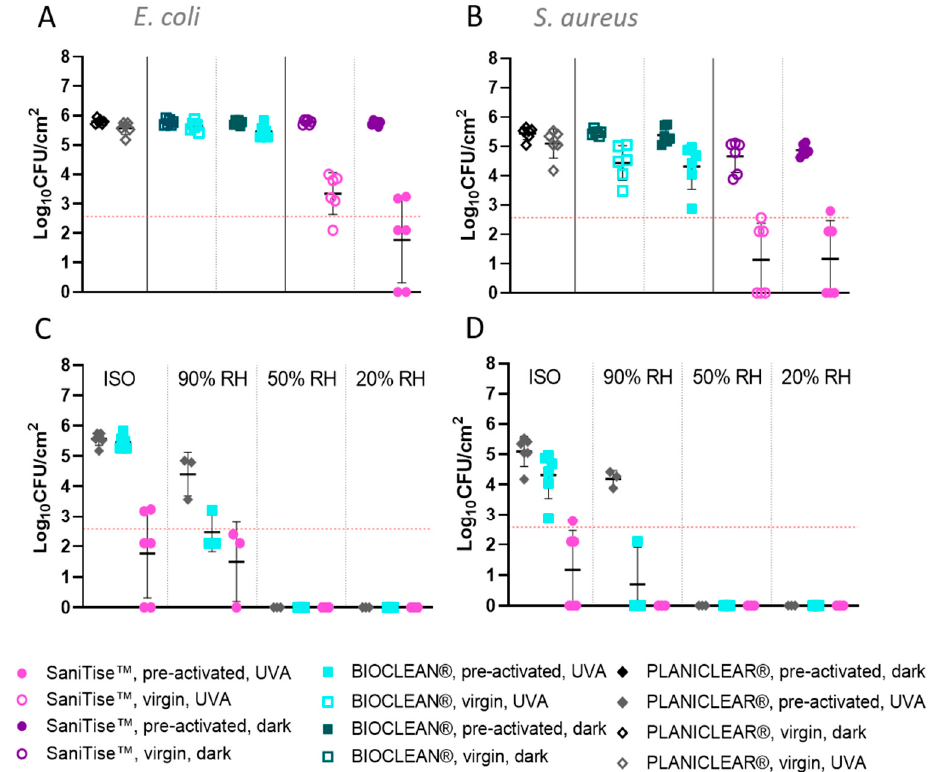
Figure 6. Antibacterial activity of the glass surfaces in ISO test format ( A , B ) and at different relative humidity conditions ( C , D ) after 4 h low-intensity UVA irradiation or dark exposure. Decrease in viable counts of Escherichia coli ( A , C ) and Staphylococcus aureus ( B , D ) are shown. Values at or above the detection limit of at least three colonies counted in all undiluted plated drops (red dotted line) was used for the statistical analysis of CFU counts. Lower values are shown to demonstrate that growth of viable bacteria was detected in at least some repetitions.